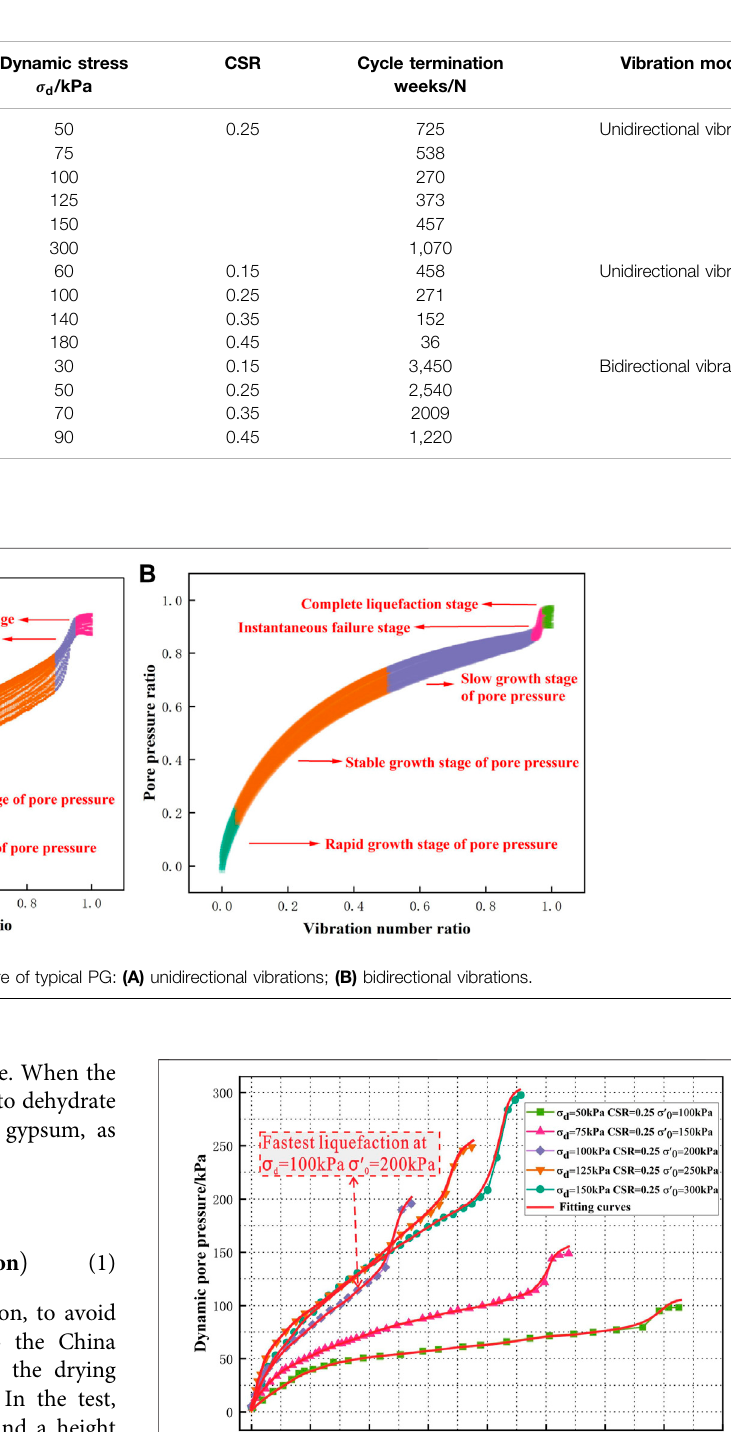
Frontiers in Earth Science |